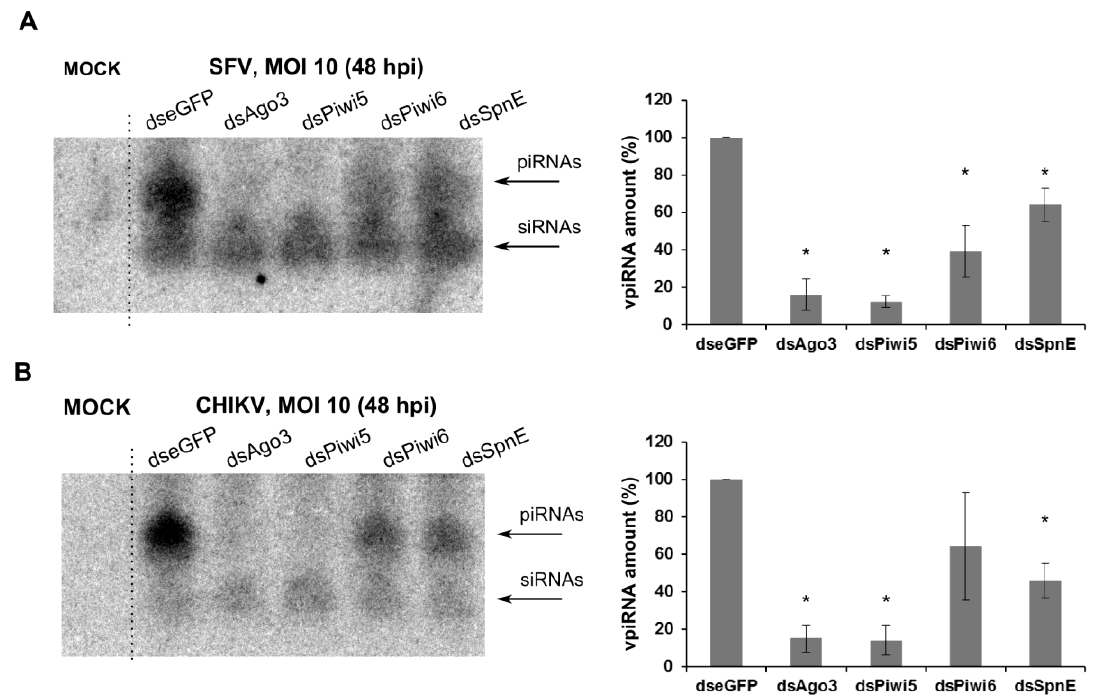
Figure 5. Northern blot analysis of virus-specific piRNAs. Aag2 cells were transfected with dsRNAs against Ago3, Piwi5, Piwi6, SpnE or eGFP (as negative control). 24 h pt the cells were infected with wt SFV ( A ) or wt CHIKV ( B ) at a MOI of 10. Total RNA isolated at 48 hpi was separated on PAGE-Urea gel, transferred onto nylon membrane and probed with virus specific radiolabelled DNA oligos for piRNAs and siRNAs. In the left panel, a representative image of three independent experiments is shown; in the right panel the mean levels of three independent experiments with standard deviation of SFV- or CHIKV-specific vpiRNAs are shown, * indicates significance, p < 0.05 (Student’s t -test); vpiRNA levels in control dseGFP treated cells taken as 100%.